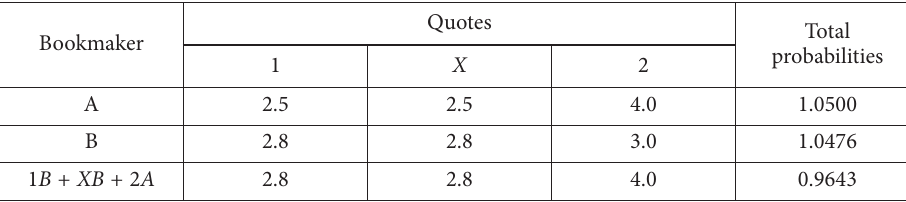
Table 2. Unreconciled quotes (source: own processing) Quotes Total Bookmaker probabilities 1 X 2 A 2.5 2.5 4.0 1.0500 B 2.8 2.8 3.0 1.0476 1 B + XB + 2 A 2.8 2.8 4.0